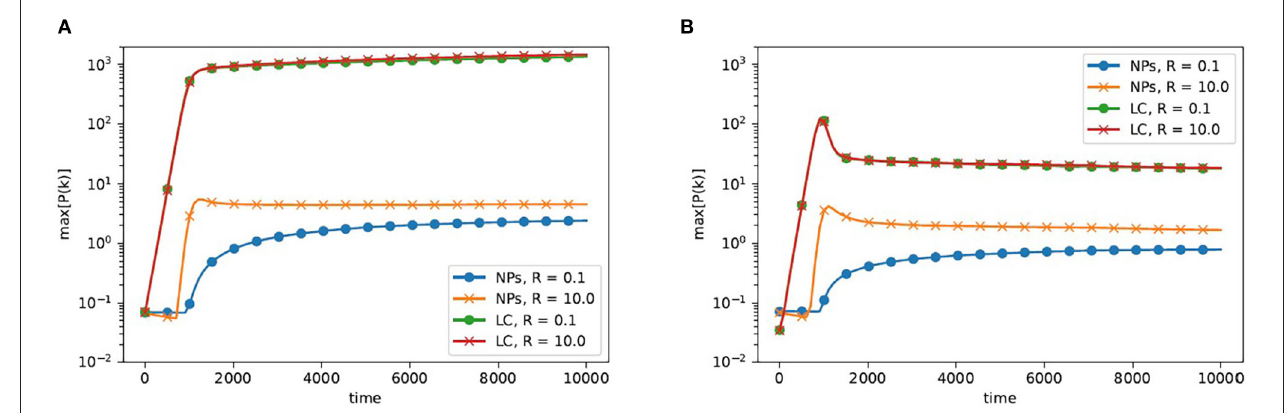
FIGURE 6 | The maxima of the power spectra of the nematization and the concentration, as functions of time, for systems with anchoring parameter λ low and high NP mobility, from (A) the scalar dynamical Equations (9) and from (B) the tensor Equations (14). In both (A,B) circles correspond to low NP mobility R 0.1 while crosses correspond to fast NP mobility R = with respect to the saturation value in the tensor case (B) . On the other hand, the exponential growth of the concentration maxima lags behind the growth of the nematization maxima, but it is also followed by saturation. The lag period is shorter for the case of high NP mobility. Parameters g fixed through the